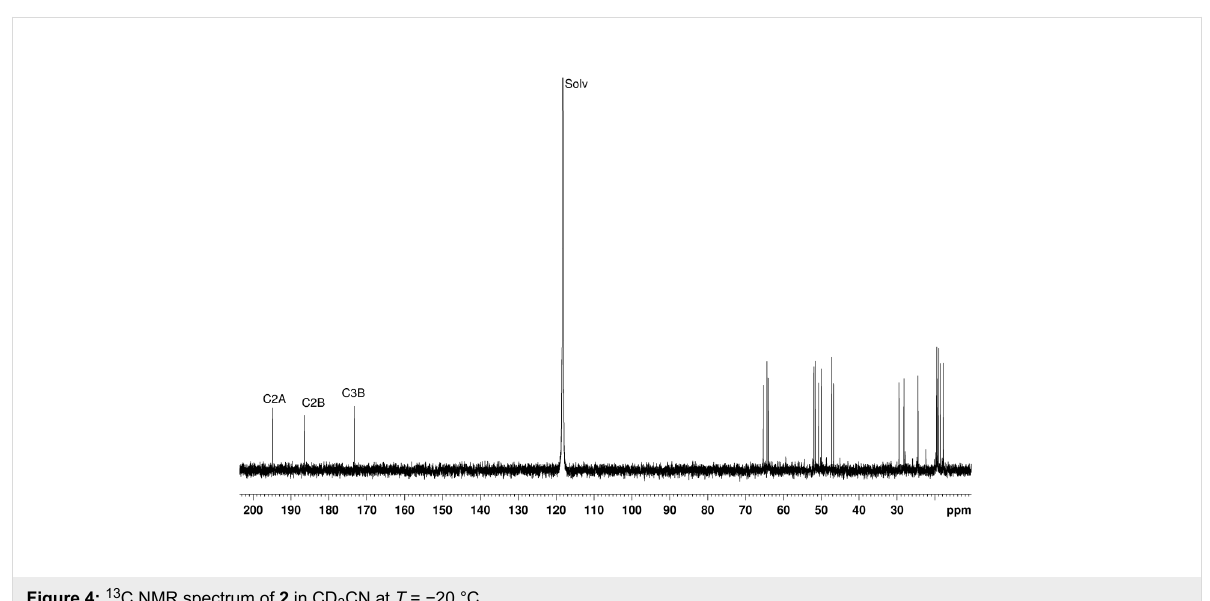
Figure 4: 13 C NMR spectrum of 2 in CD 3 CN at T = − 20 °C.